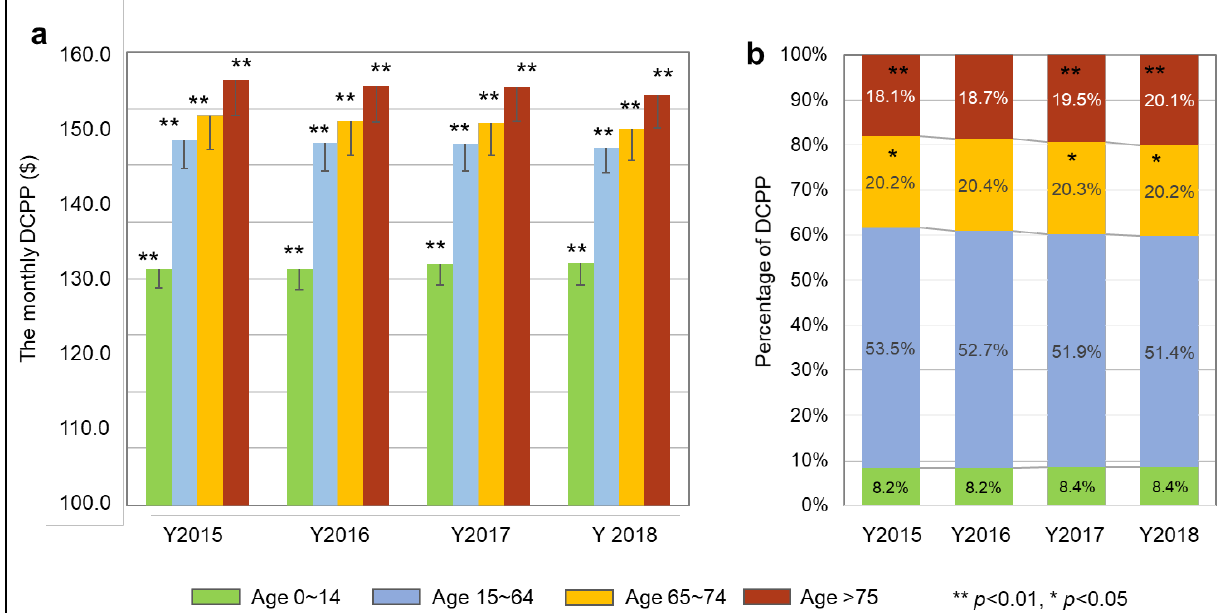
Figure 3. Association between age levels and DCPP. ( a ): Average monthly DCPP in 4 age groups. A statistically significant difference ( p < 0.01 **, One-way ANOVA and Tukey HSD test) in DCPP among the age groups was observed, showing that as people age, they spend more on dental services. ( b ): Proportion of DCPP in 4 age groups. The 2017 and 2018 monthly DCPP proportion for the 75+ group was significantly greater than in 2015 ( p < 0.01 **). Table 2. Association between demographic and socioeconomic characteristics and DCPP.